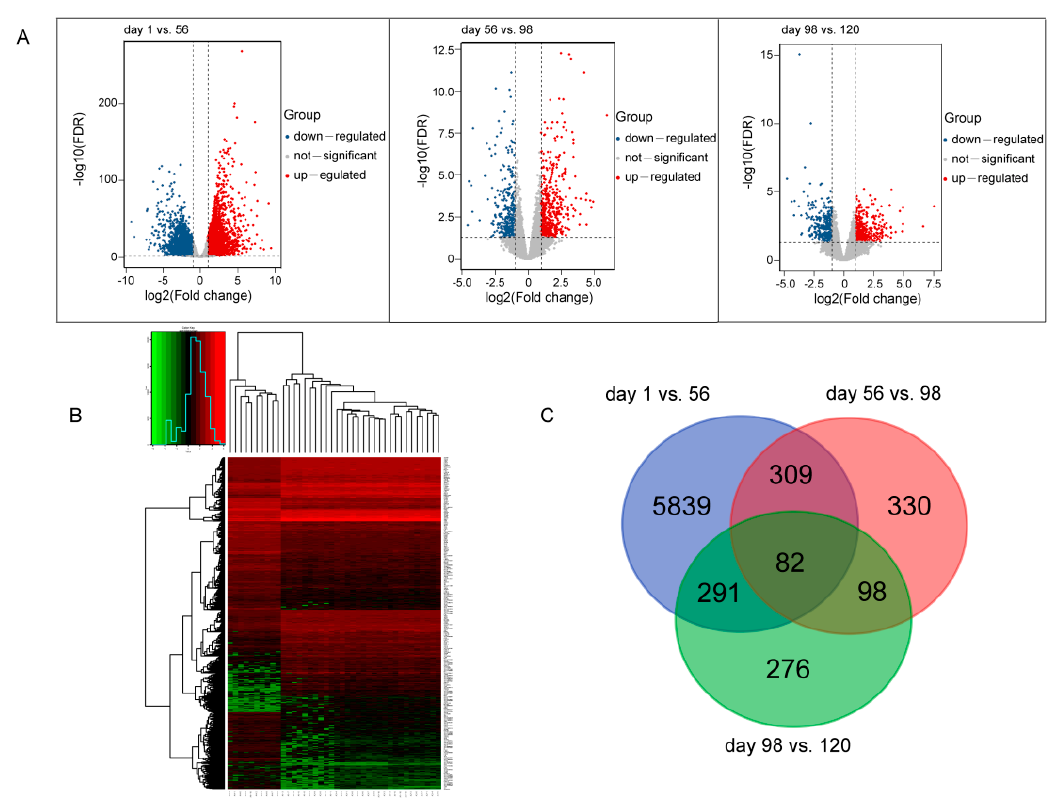
Figure 1. Differential expression analysis of mRNAs of breast muscle at four developmental stages of Beijing-You chicken (BJY). ( A ) Differentially expressed genes (DEGs) between different stages. ( B ) Heatmap of DEGs by cluster analysis. ( C ) Venn diagram plot of